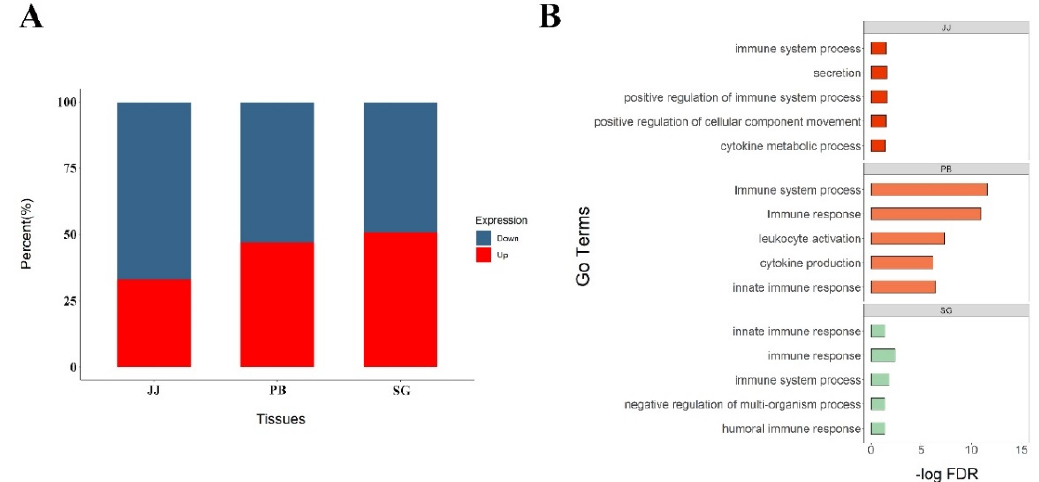
Figure 1. Results of differential expressed analysis. ( A ) The percentage of up–expressed and down– expressed genes of three tissues in infected cows, red parts mean the percent of up–expressed genes, and blue parts mean down–expressed genes; ( B ) Pathway enrichment of differential expressed genes in different tissues.